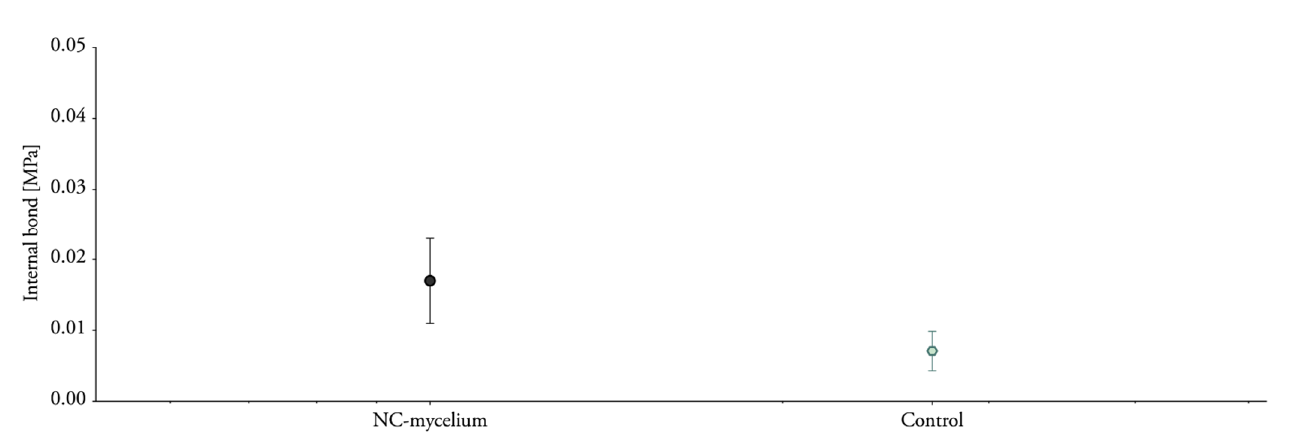
Figure 11. Detail of specimens and fixtures before and after loading for tension tests perpendicular to the surface (internal bond).